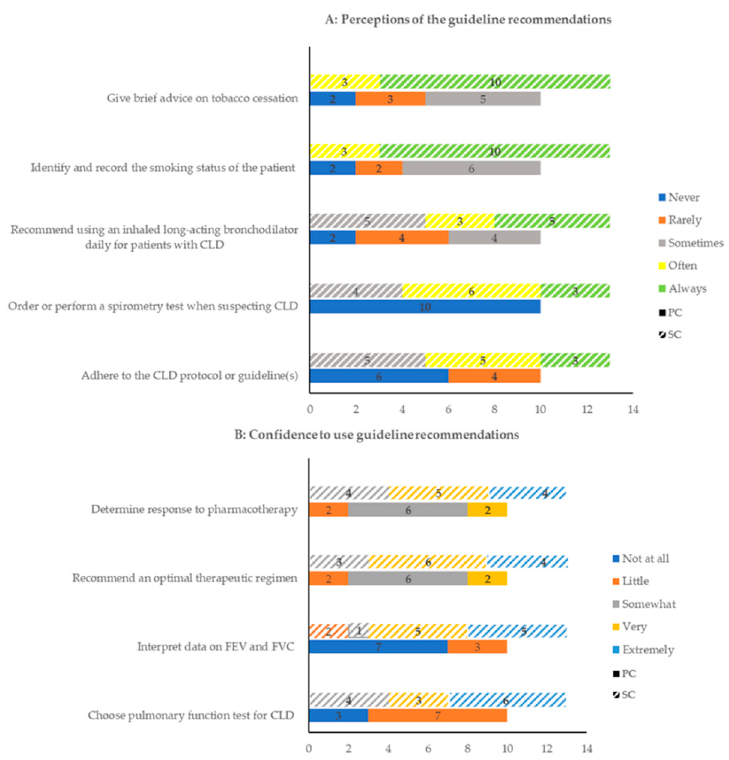
Figure 2. Perceptions of and confidence in using the guideline recommendations in practice by healthcare professionals (HCPs) in primary care (PC) and secondary care (SC).